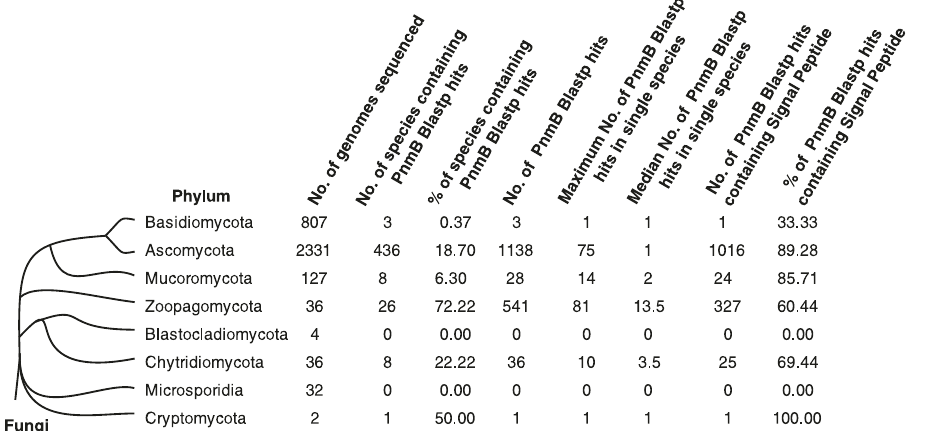
Fig. 4 Distribution of PnmB BLASTP hits in the fungal kingdom. Phylum-level distribution of PnmB BLASTP hits across eight phyla of the fungal